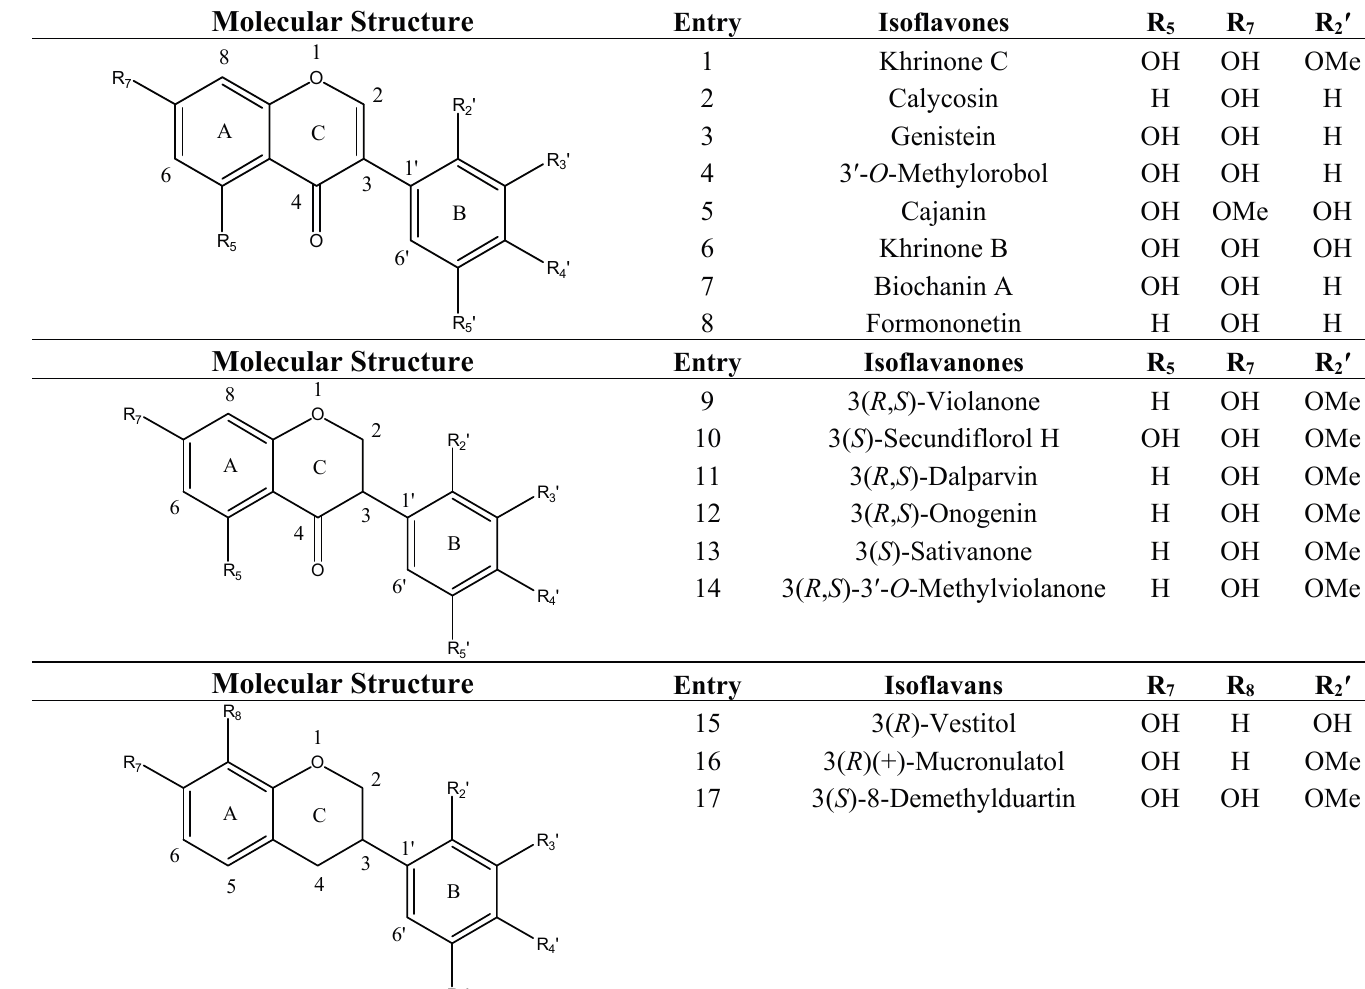
Table 1. Molecular structure of isoflavonoids from Dalbergia parviflora . Molecular